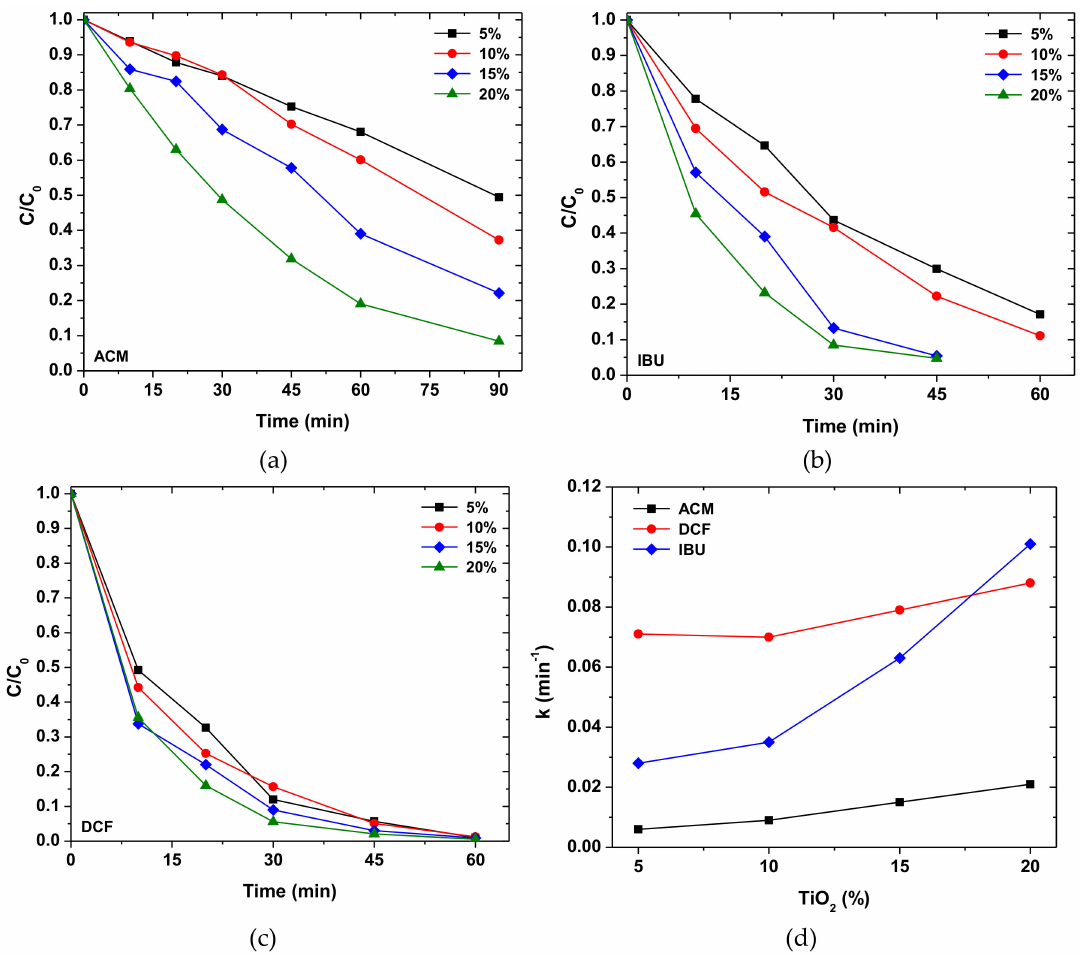
Figure 5. Effect of TiO 2 amount immobilization at the efficiency of the anti-inflammatory drug mixture degradation under SSL, ( a ) ACM; ( b ) IBU; ( c ) DCF; ( d ) variation of degradation kinetic rate (k) versus TiO 2 % content, (C o (drug) = 5 mg L − 1 ); and (C(catalyst) = 600 mg L − 1